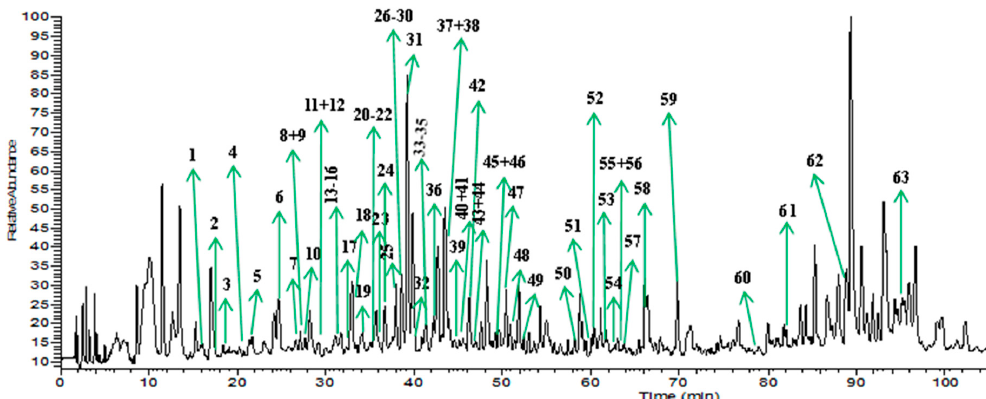
Figure 2. TIC chromatogram of T. sinensis in negative ion mode.